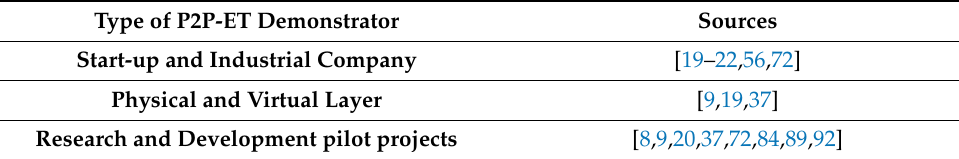
Table 2. Cluster of literature focused on P2P-ET